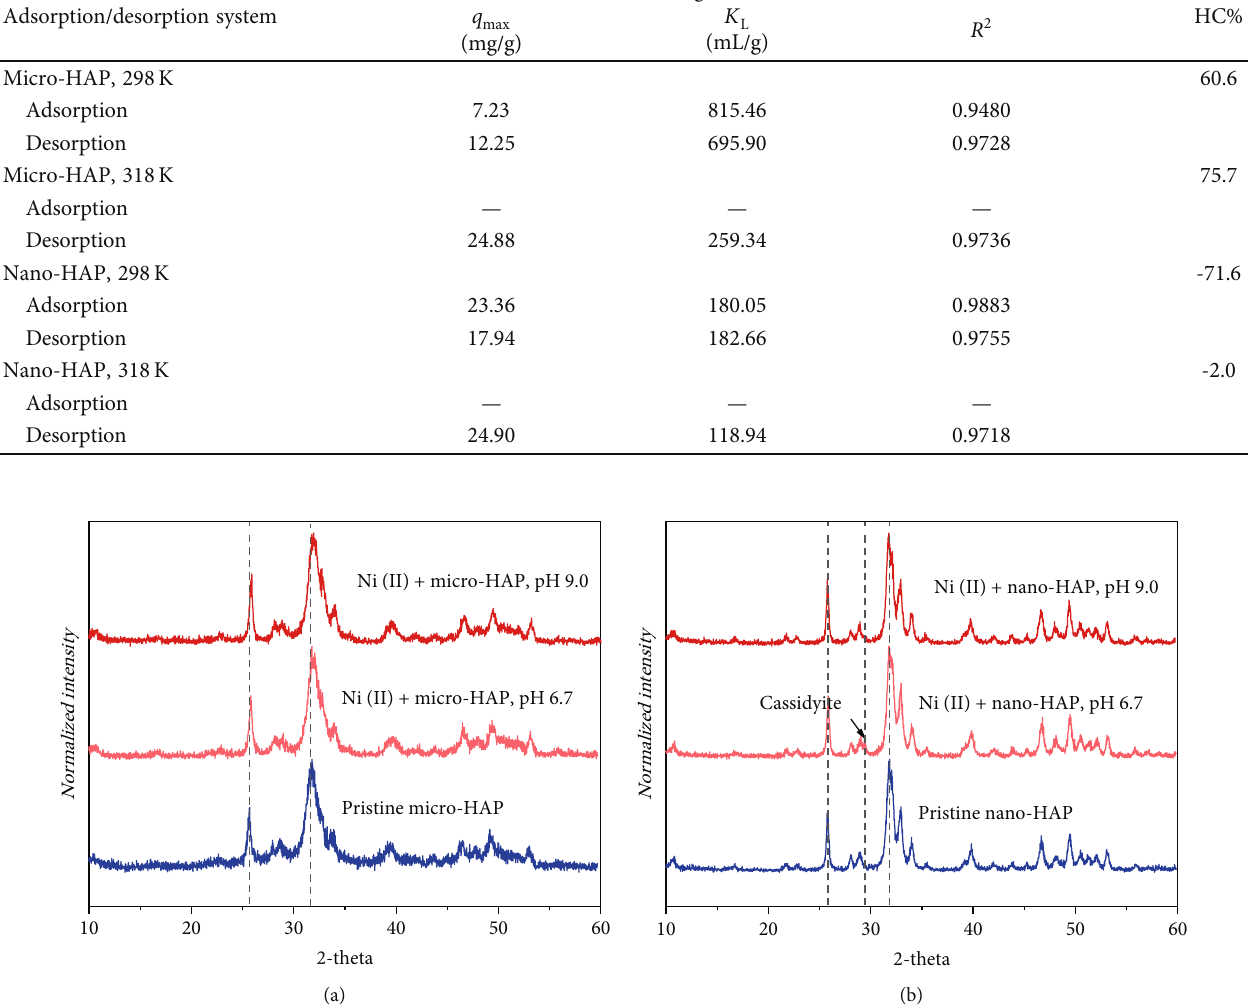
Figure 7: XRD patterns of pristine HAPs and Ni(II)-loading HAPs at pH 6.7 and 9.0. (a) micro-HAP and (b) nano-HAP.